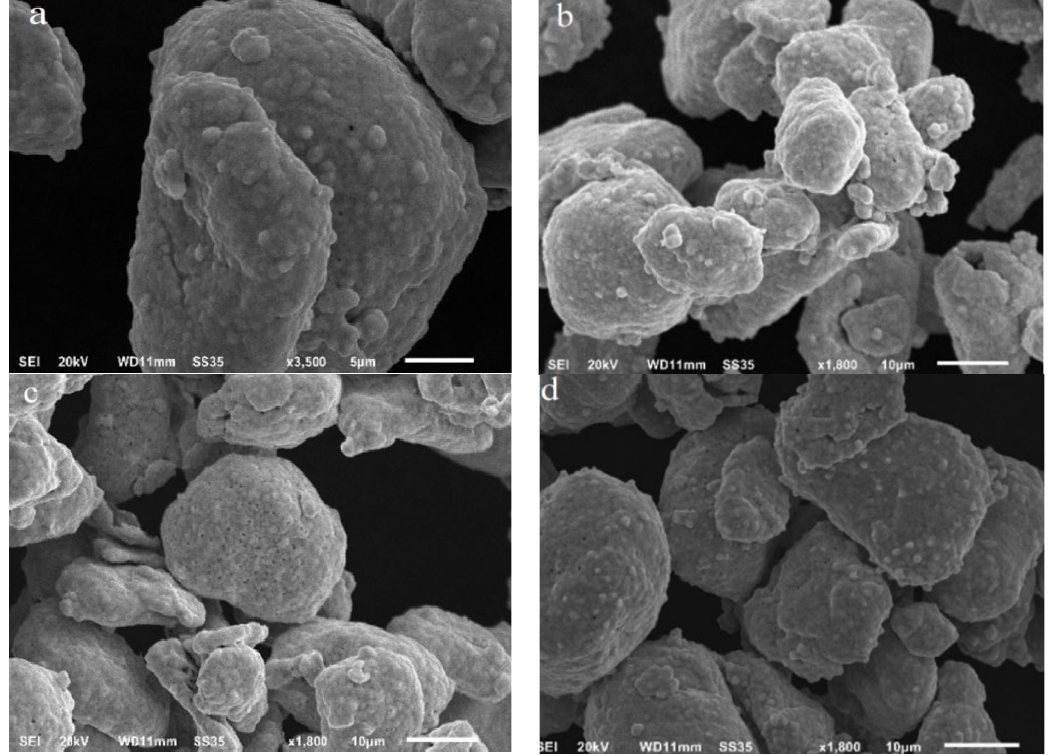
Figure 7. SEM images of Ag/Ni/C powders at diffident temperature: ( a ) 400 °C; ( b ) 500 °C; ( c ) 600 °C; ( d ) 700 °C. ( d ) 700 ◦